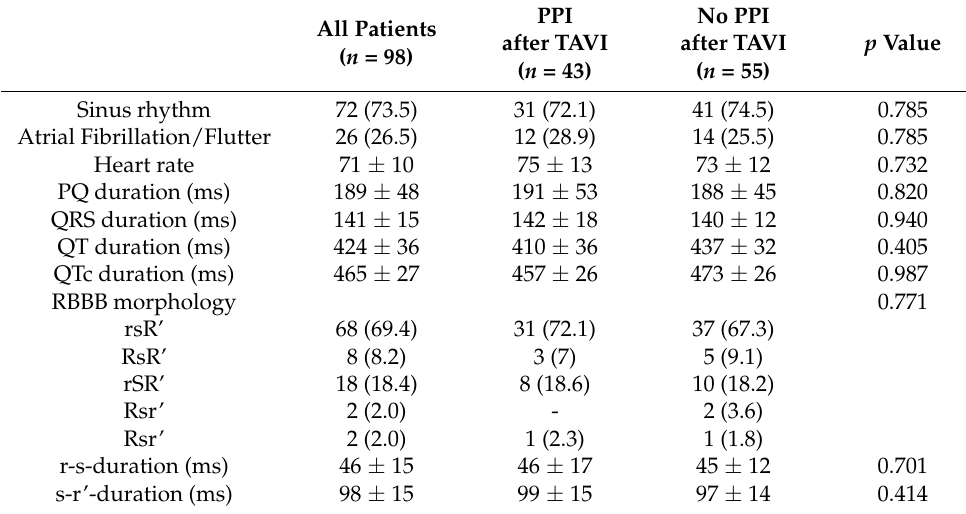
Table 3. Baseline ECG characteristics.